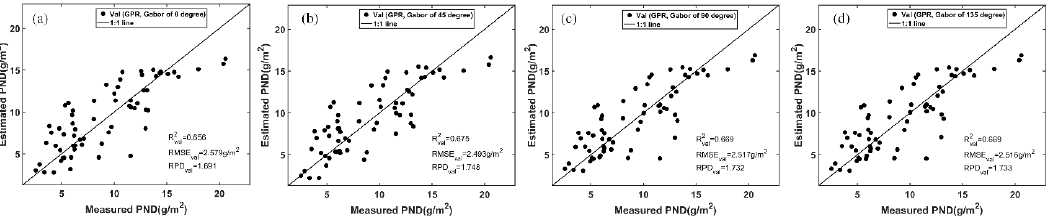
Figure 15. The predictive performance of the GPR models based on the Gabor-based textures of each orientation for the estimation of PND in winter wheat ( a – d ).